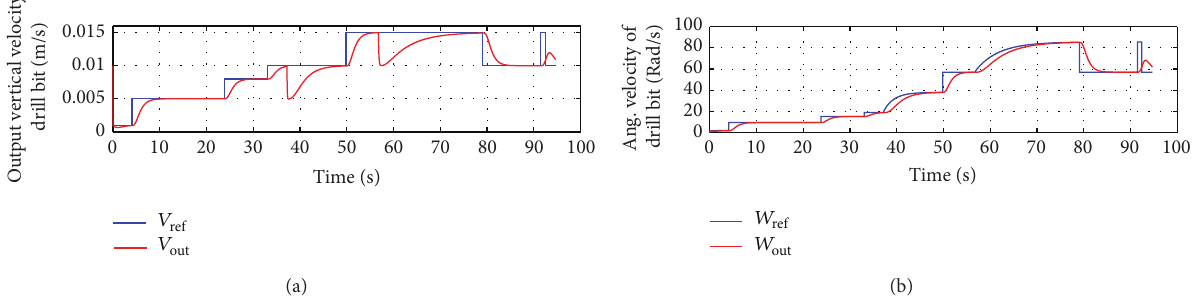
(𝑡) versus reference vertical velocity V out (𝑡) (b). 1𝑑